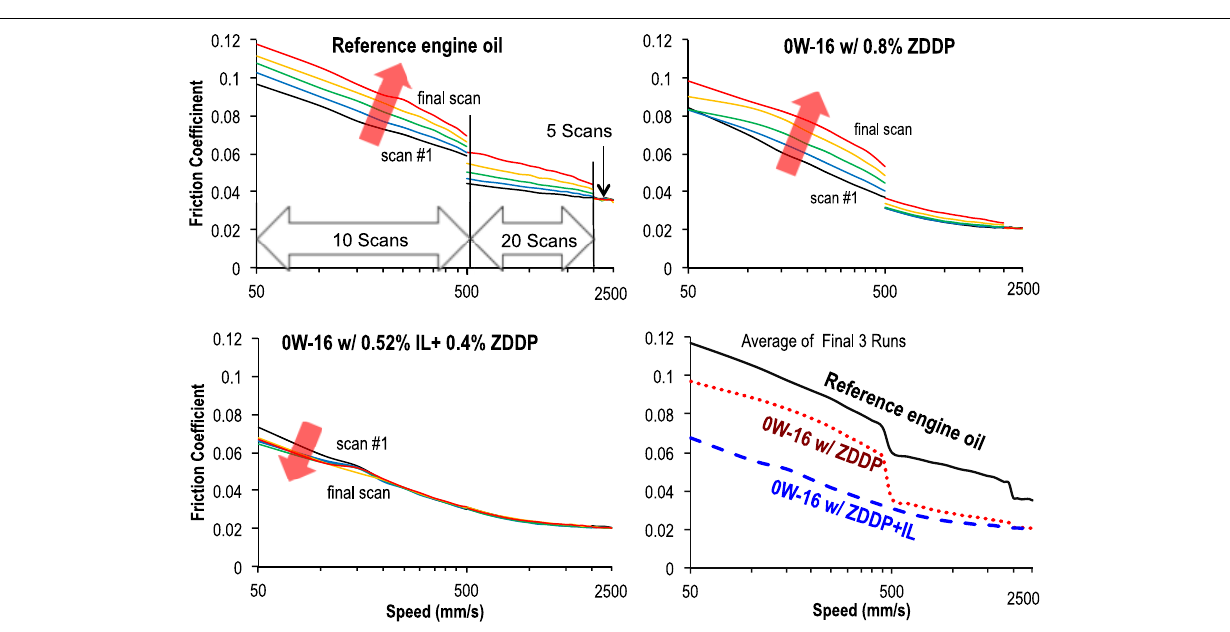
Frontiers in Mechanical Engineering |